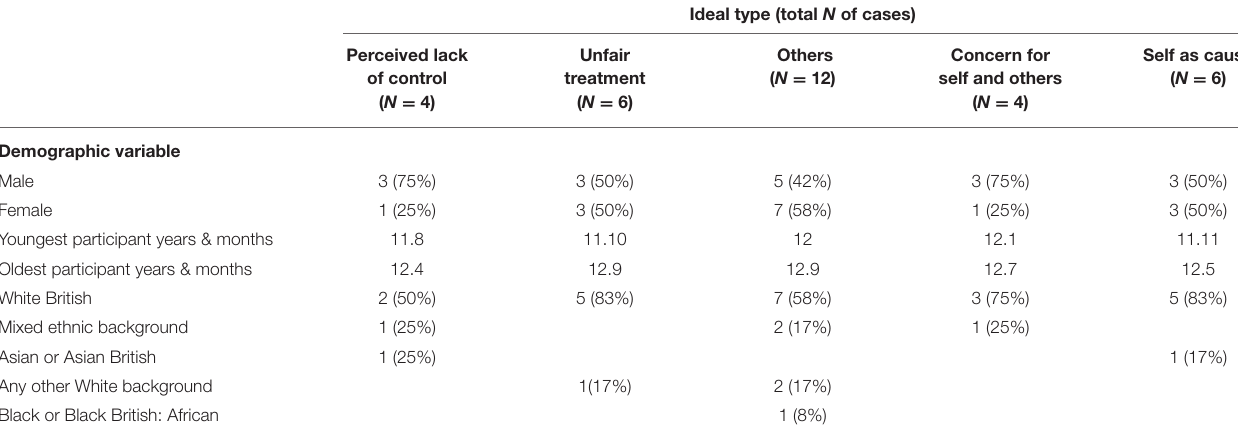
TABLE 2 | A summary of the demographic data for the young people included in the study, organized by ideal